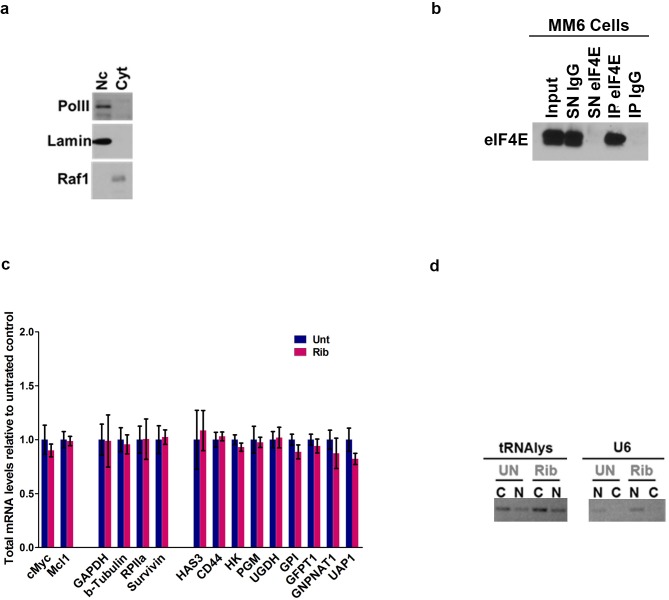
eIF4E elevates HA in cancer cell lines and primary specimens.(A) Control western blot for cellular fractionation corresponding to eIF4E RIP. Lamin and Pol II are used as nuclear markers while Raf1 is used as cytoplasmic marker. (B) Control western blot of eIF4E recovered in immune complexes with eIF4E antibodies and IgG relative to input amount of eIF4E corresponding for RIP in MM6 cells in Figure 3. (C) RT-qPCR of total mRNA levels corresponding to mRNA export assay in untreated cells (UN) or Ribavirin treated (Rib). (D) Semi-qPCR for tRNAlys and U6 snRNA served as controls for the cytoplasmic and nuclear fractions, respectively, for Figure 3.